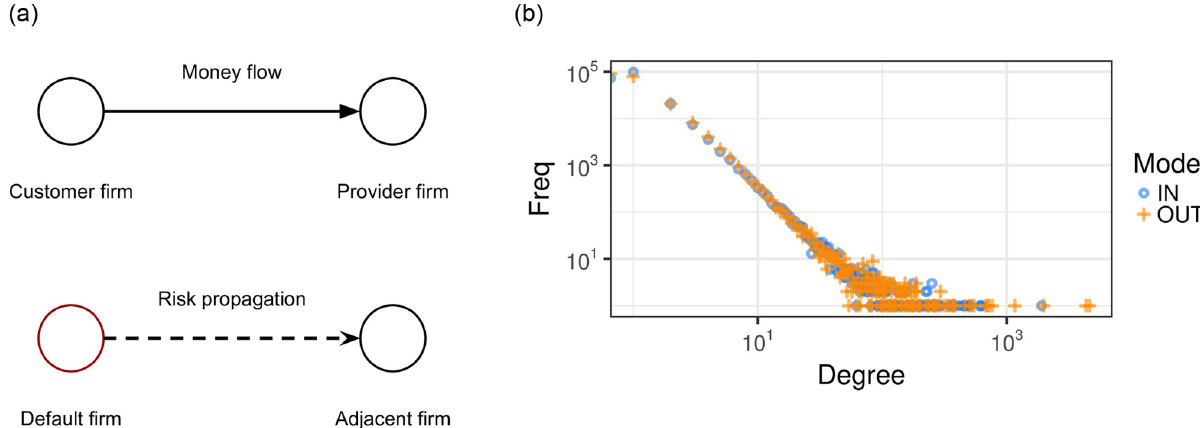
Fig 2. (a) A component of the inter-firm business transaction networks. The nodes are firms and links are business transactions from customers to providers, indicating a money flow and thus a possible trade debt. In a similar way, we assume that also the risk flow, i.e., propagates, between adjacent nodes. The nodes are firms and links are risk propagations from an insolvent firm to its adjacent nodes. (b) degree distribution of the transactions networks (blue points correspond to incoming degree ( k ) while orange to outgoing degree ( k )). The degree of the networks shows a typical scale free in out distribution, i.e. y * k γ : here γ = − 2.54 and γ = − 2.50 for the incoming and outgoing nodes’ degree distribution.